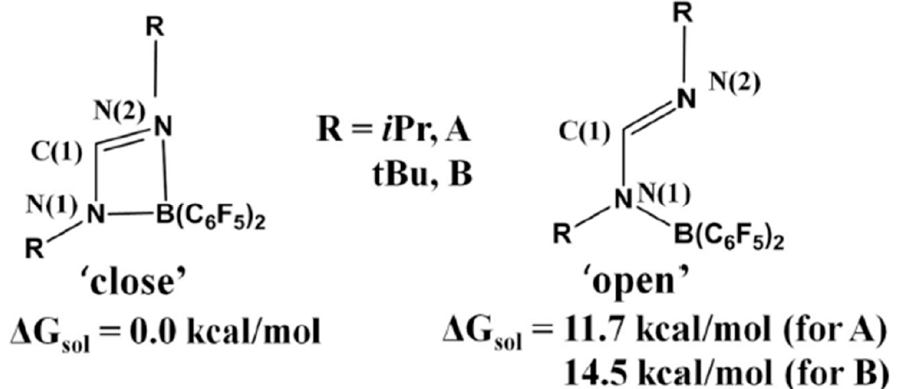
Figure 5. Schematic representation of two isomers of boron amidinate FLPs A and B. (Reprinted from ref. [87] with permission from Springer Nature. Copyright © 2022, Springer Science Business Media, LLC.).